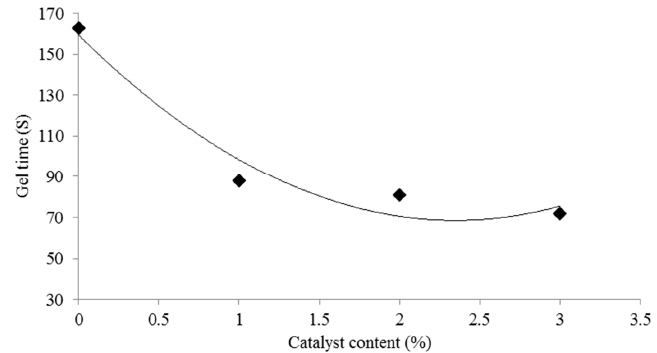
Figure 3. Effect of acidic ionic catalyst content on gel time of UG resin.